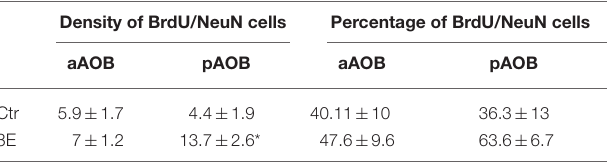
TABLE 2 | Density and percentage of BrdU/NeuN positive cells in the GrL of the AOB in control (Ctr) and three ejaculation (3E) groups. Density of BrdU/NeuN